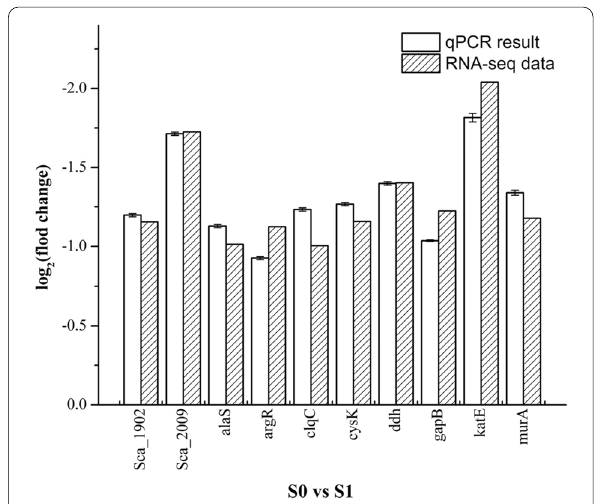
Fig. 6 Validation of RNA-seq data by